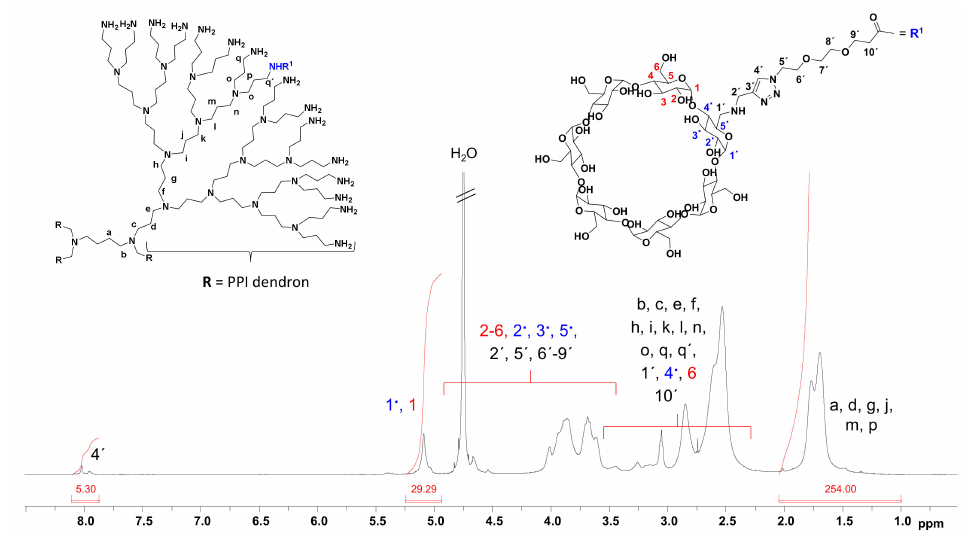
Figure A5. 1 H NMR spectrum of CD-PPI (G4) in D 2